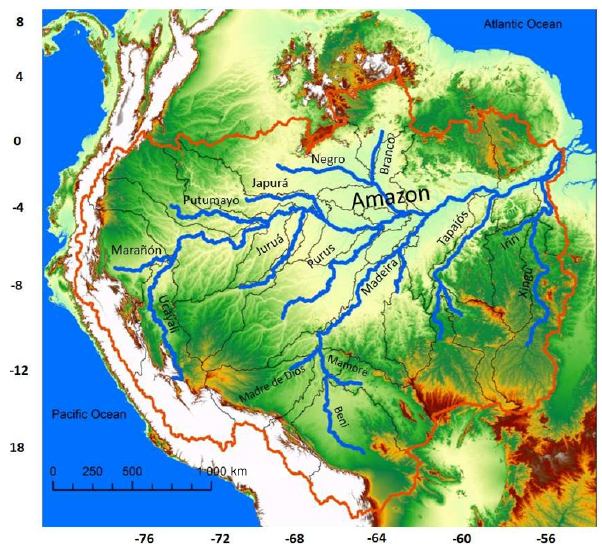
Figure 2. Monthly averages from 2011 to 2015 of the SWAF sur- face water fractions over the Amazon basin based on vertical po- larization brightness temperatures (TB V) at 32.5 ◦ incidence angle acquired by the SMOS